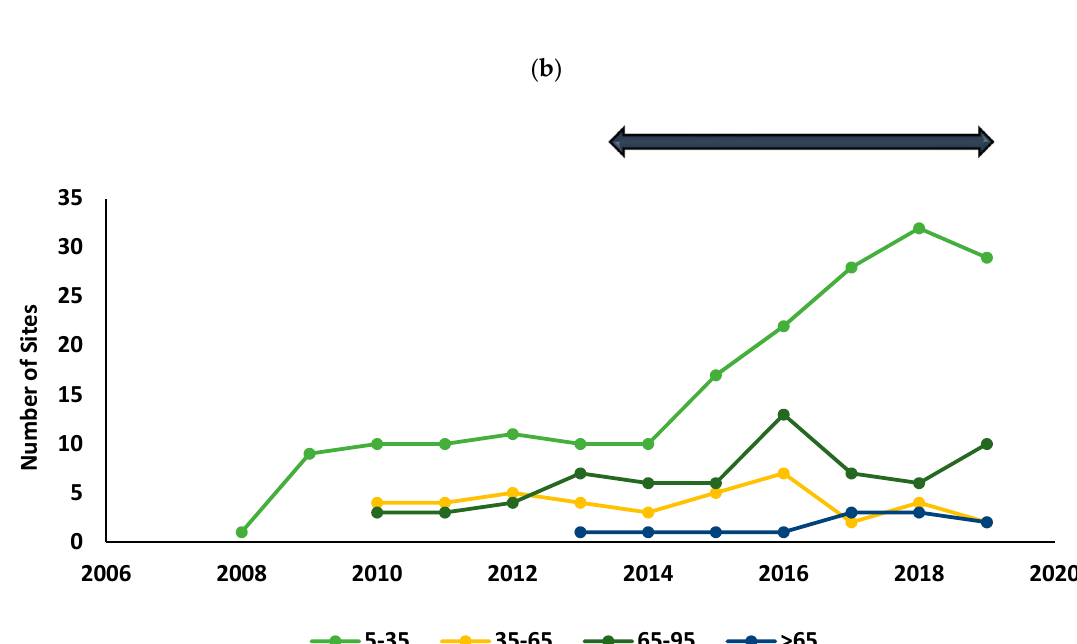
Figure 4. The extent of Sagittaria platyphylla infestations in South Africa from 2008 to 2019, categorised as the total number of sites with a particular population size category ( a ) and plant density ( b ) recorded each year. The black arrow across the top indicates the initiation of management options, including mechanical and chemical control.